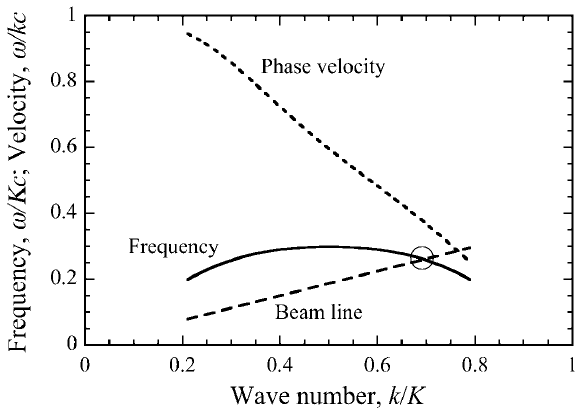
FIG. 2. Frequency (solid line) and phase velocity (dotted line) of the evanescent wave for the grating used by Urata and Walsh. The dashed line is the beam line ( (cid:6)k=K ) for 40 keV electrons. The operating point for 40 keV electrons (circled) is the intersection of the frequency curve with the beam line.